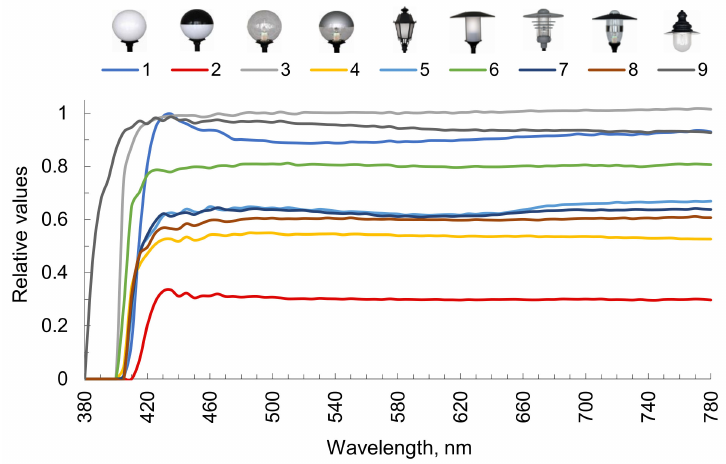
Figure 10. Spectral curves of the luminaires determined on the basis of